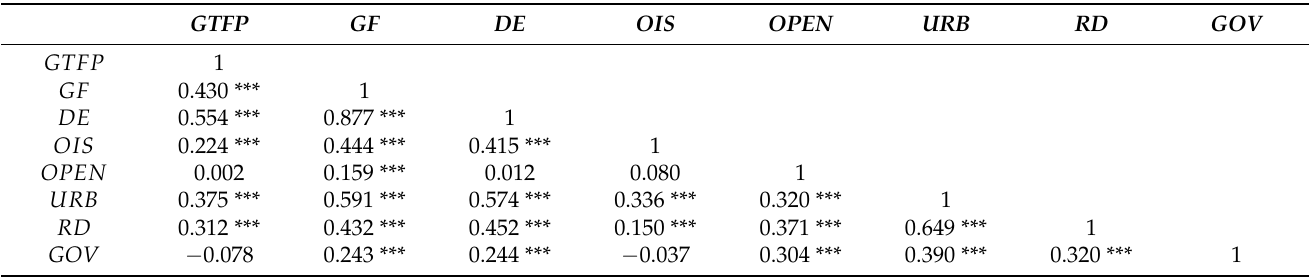
Table 4. Correlation